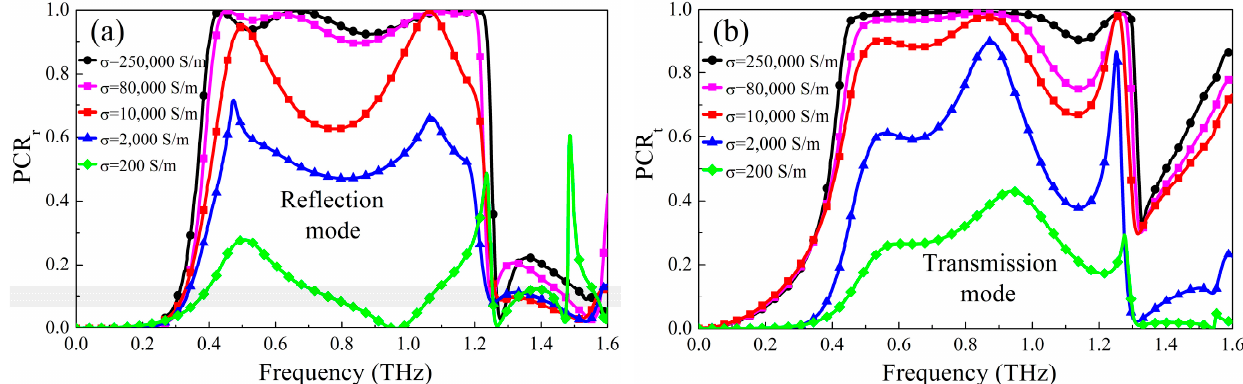
Figure 4. The PCR under different intensities of bump light ( a ) Reflection mode; ( b ) Transmission mode. Table 1. Comparison with existing polarization